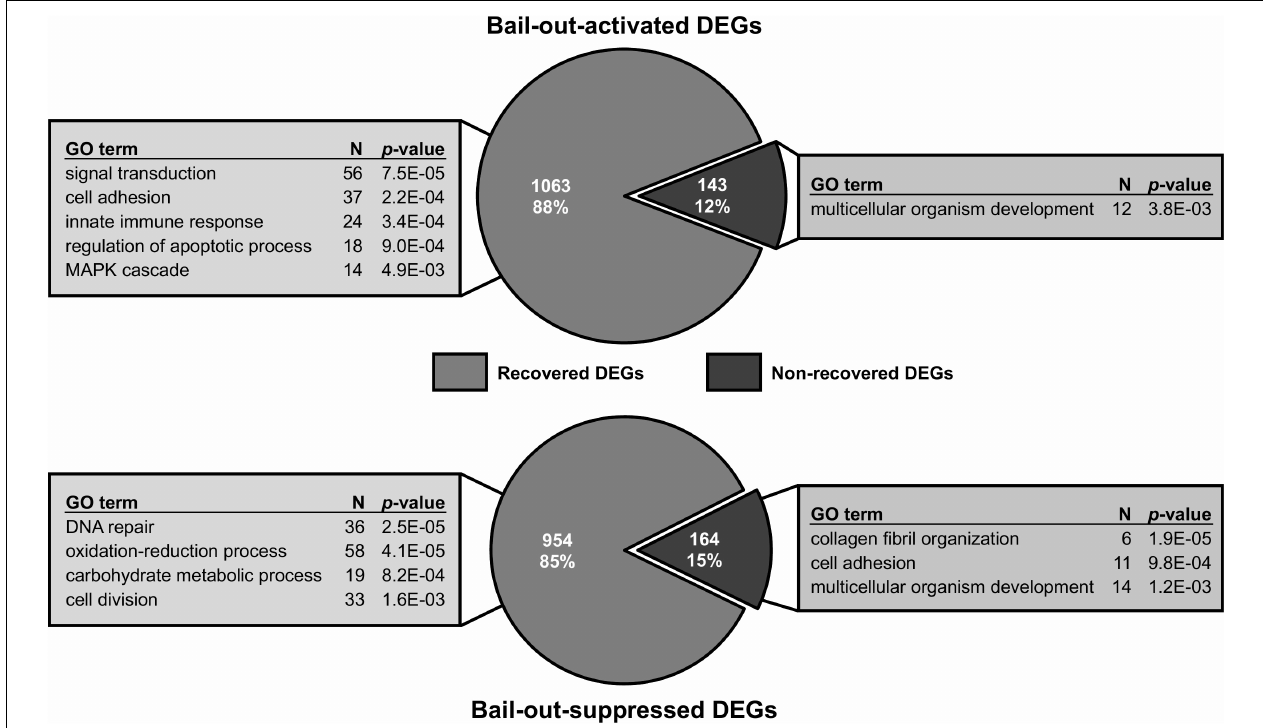
FIGURE 4 | Recovery of bail-out-induced genetic changes in recovered polyps at day5 post-bail-out. Numbers of differentially expressed genes (DEGs) up- or down-regulated during polyp bail-out and significantly overrepresented gene ontology (GO) categories ( p < 0.005) are displayed. The number of unique genes in each GO category is